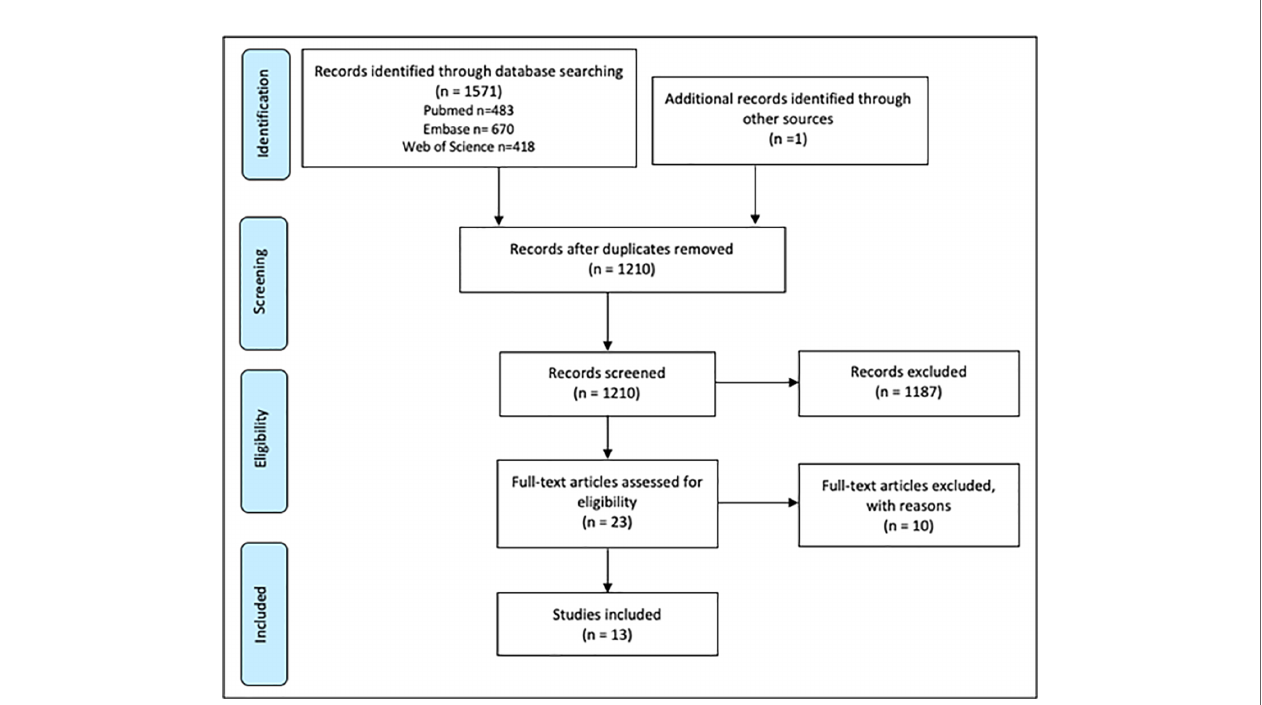
FIGURE 1 | Literature search, strategy, and